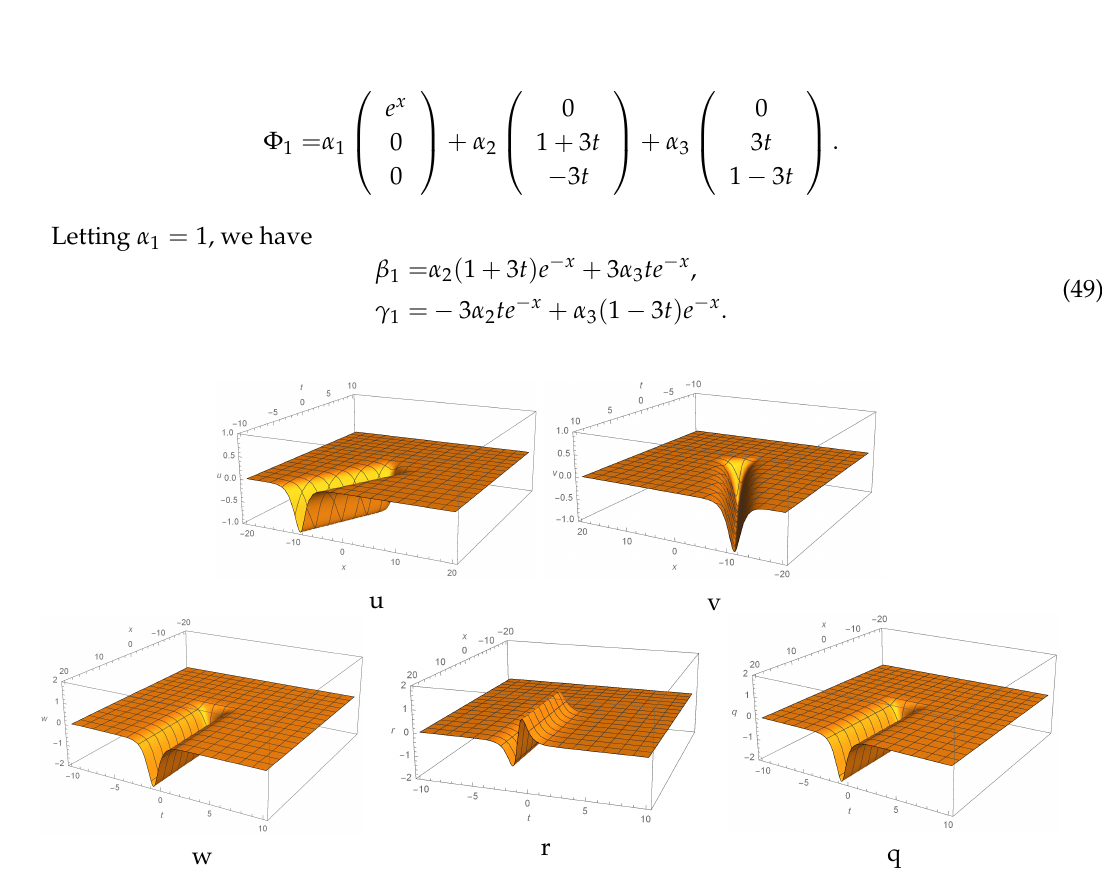
Figure 1. A soliton-like